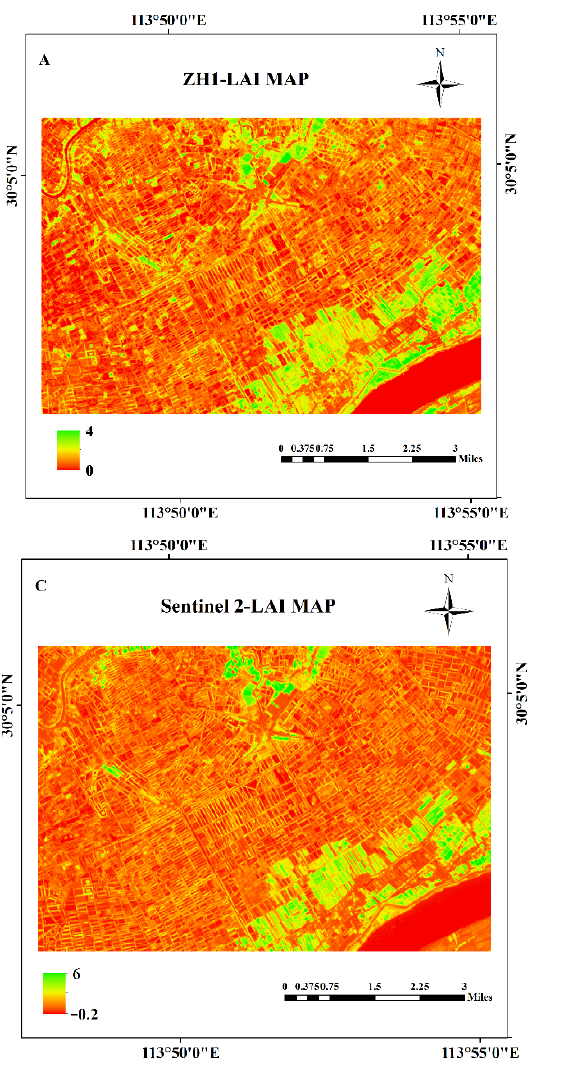
Figure 6. ( A ): LAI map of the study area using the optimal band combination of ZH-1 hyperspectral satellite; ( B ): NDVI map of the study area with Sentinel-2 image; ( C ): LAI map of the study area using Sentinel-2 hyperspectral satellite; and ( D ): correlation between ZH-1 LAI and Sentinel-2